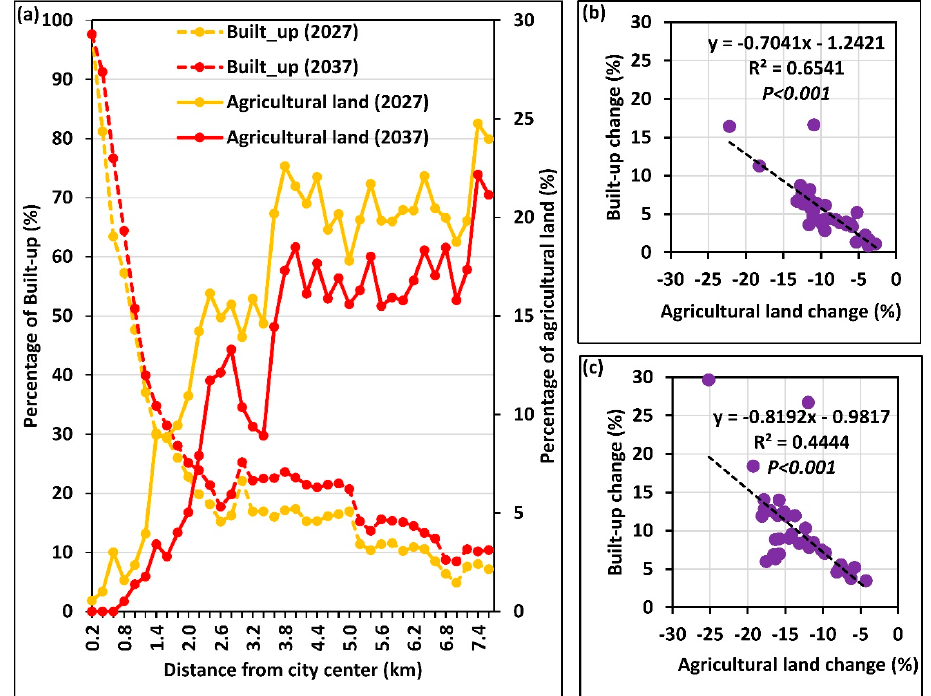
Figure 7. The spatial pattern of the changes in agricultural and built-up land in the Nuwara Eliya area in 2027–2037: ( a ) Agricultural and built-up land across the gradient; ( b ) Scatter plot between agricultural and built-up changes in 2017–2027; and ( c ) Scatter plot between agricultural and built-up changes in 2017–2037.